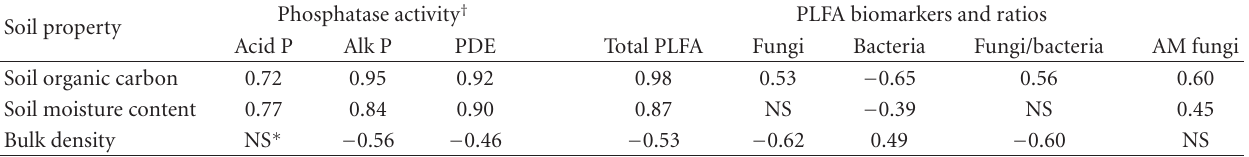
Table 5: Correlation coe ffi cients between soil physicochemical and biochemical variables determined in the study. Soil property